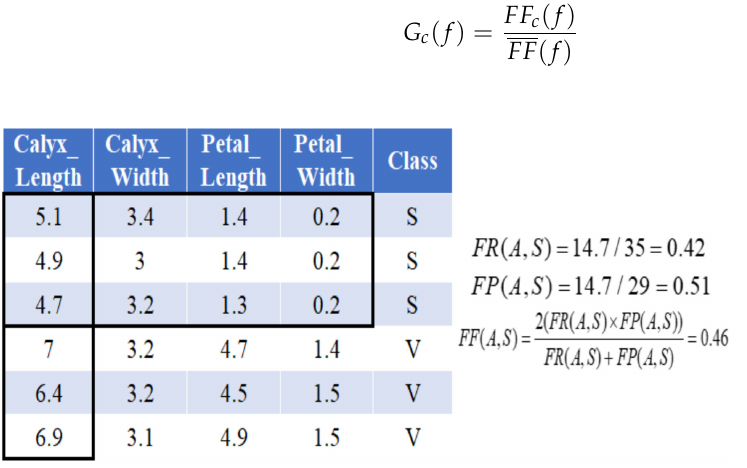
Figure 1. Principle of feature F measure computation for sample data.